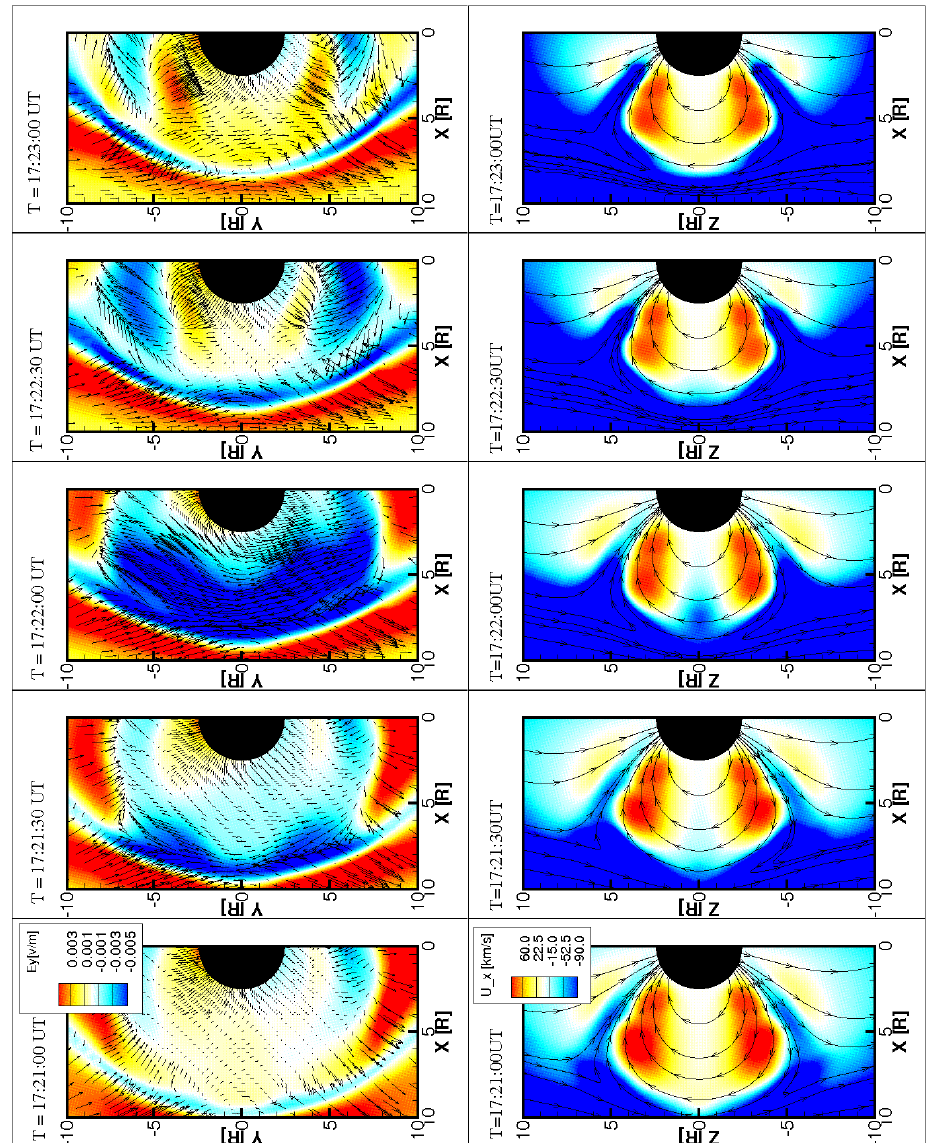
Fig. 5. Upper row: electric fields on equatorial plane. Color represents the dusk-to-dawn (Y) component of eletric fields, and black arrows are vectors of electric fields on the plane (i.e., in both x and y components). Lower row: Snapshots of V x in the dayside magnetosphere on the Y=0 plane. Color represents the velocity, and the lines are the magnetic field lines. Note that the magnetosphere is slightly stretched in the x axis compared to the y